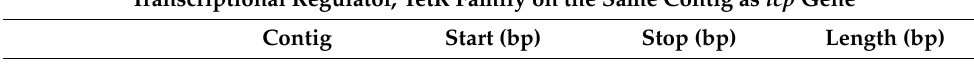
Table A6. Distribution and loci of β -oxidation related putative genes in the draft genome of Microte- traspora sp. AC03309 based on RAST server